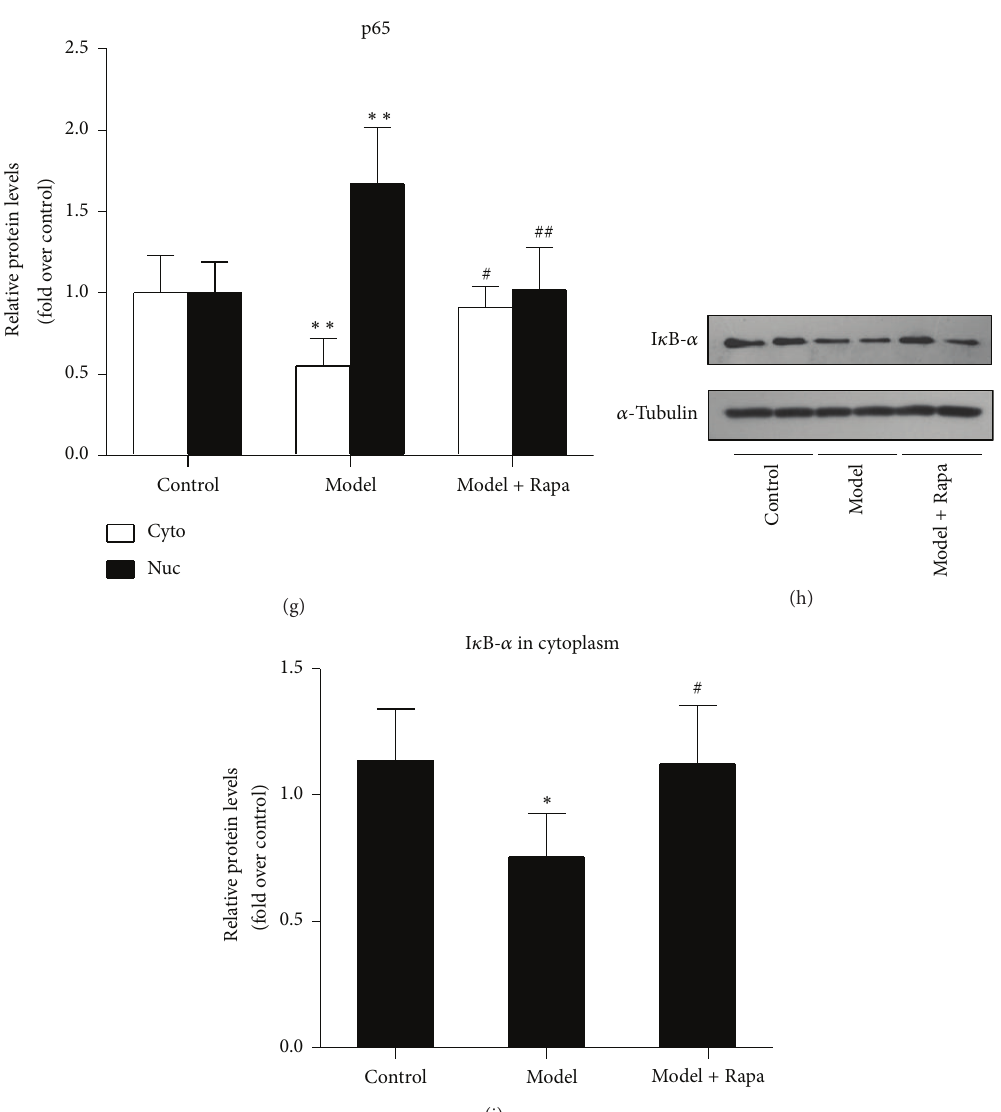
Figure 2: Rapa maintained energy homeostasis and inhibited NF- 𝜅 B activation in hypertrophied hearts induced by isoproterenol. (a) The ultrastructures of the mitochondria were analyzed under TEM. Transmission electron micrographs of histological sections from the apex of left ventricle with different treatments were shown. Black arrows indicate disorganized cristae and vacuoles of mitochondria in the hypertrophied hearts. White arrows indicate autophagosomes. Scale bars, 1 𝜇 m. (b) State III and state IV respiration rates. (c) Respiratory control rate (RCR) was calculated as the ratio of state III respiration rates to state IV respiration rates. Values represented as mean ± SD of 6 rats in each group. (d) ATP production. Values represented as mean ± SD of 6 rats in each group. (e) Expression of metabolic genes associated with fatty acid metabolism at mRNA levels. The mRNA was prepared and normalized to 𝛽 -actin gene. Values represented as mean ± SD of 4 to 5 rats in each group. ((f) and (h)) Cytoplasmic and nuclear extracts from left ventricles of three groups of rats were immunoblotted with anti-p65 and anti-I 𝜅 B- 𝛼 antibodies. ((g) and (i)) Densitometric analysis of the relative protein expression of p65 and I 𝜅 B- 𝛼 . Histone H3 and 𝛼 -tubulin were used to normalize the nuclear and cytosolic proteins loading, respectively. Values represented as mean ± SD of 4 to 5 rats in each group. Model, the cardiac hypertrophy model induced by isoproterenol; Rapa, isoproterenol-infused rats treated with Rapa. ∗ 𝑃 < 0.05 versus control group; ∗∗ 𝑃 < 0.01 versus control group; # 𝑃 < 0.05 versus model group; and ## 𝑃 < 0.01 versus model